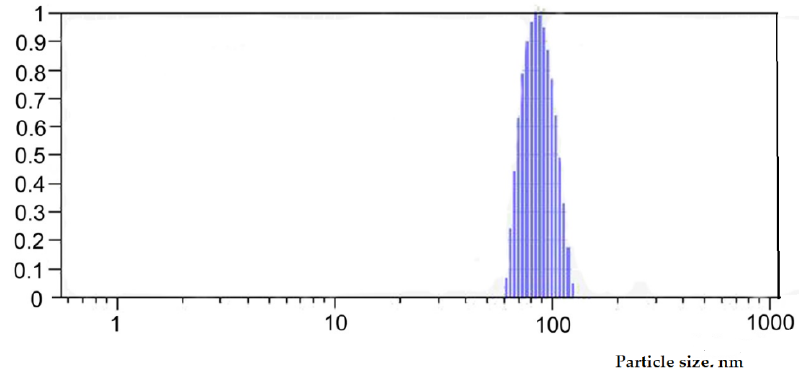
Figure 7. Selenium particle size distribution of colloidal solution.